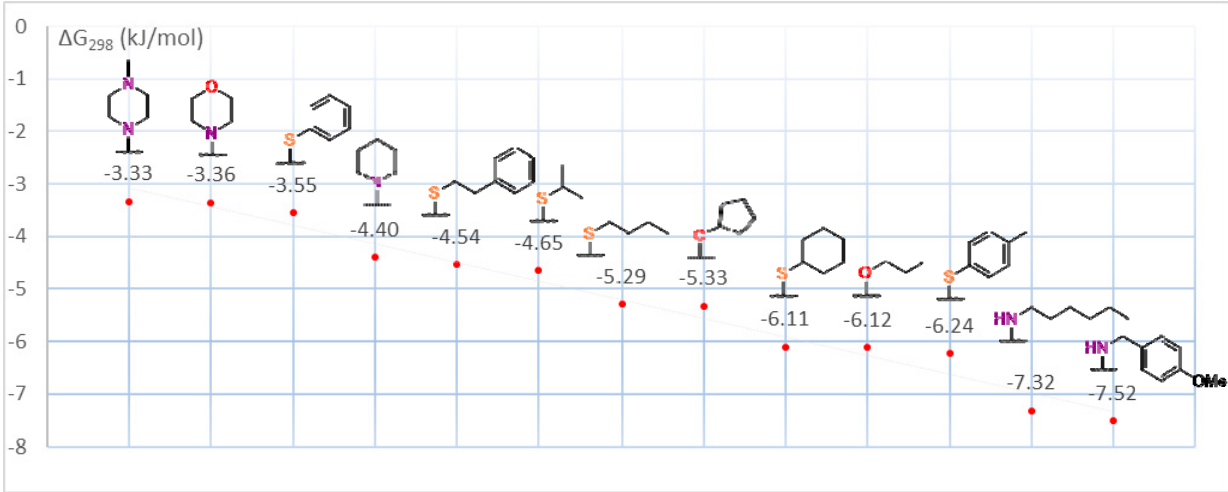
Figure 2. Composition of the Gibbs free energy of tautomerization for the substituted tetrazoles 3 – 5 .